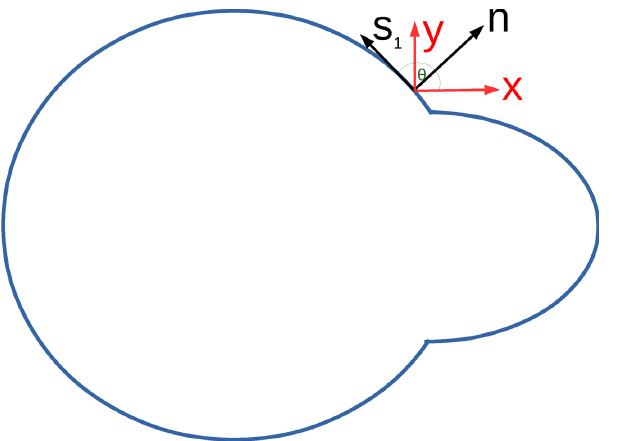
Fig 3. A cartoon of a deforming nucleus in 2D showing the coordinate basis ( n , s 1 , s 2 ) used for the shell model compared to the Cartesian coordinate system used in the 2D images. NB s 2 is out of the